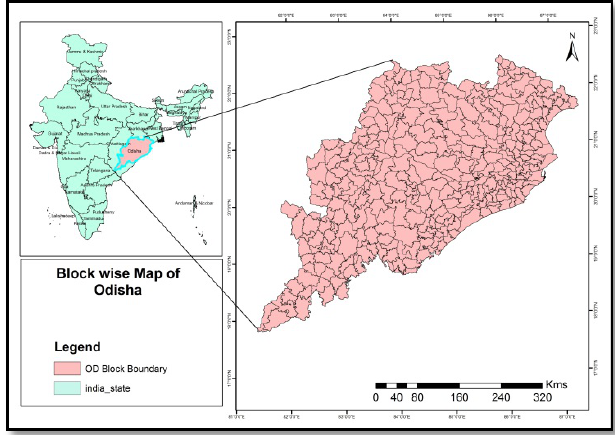
Figure 1: Study area Odisha